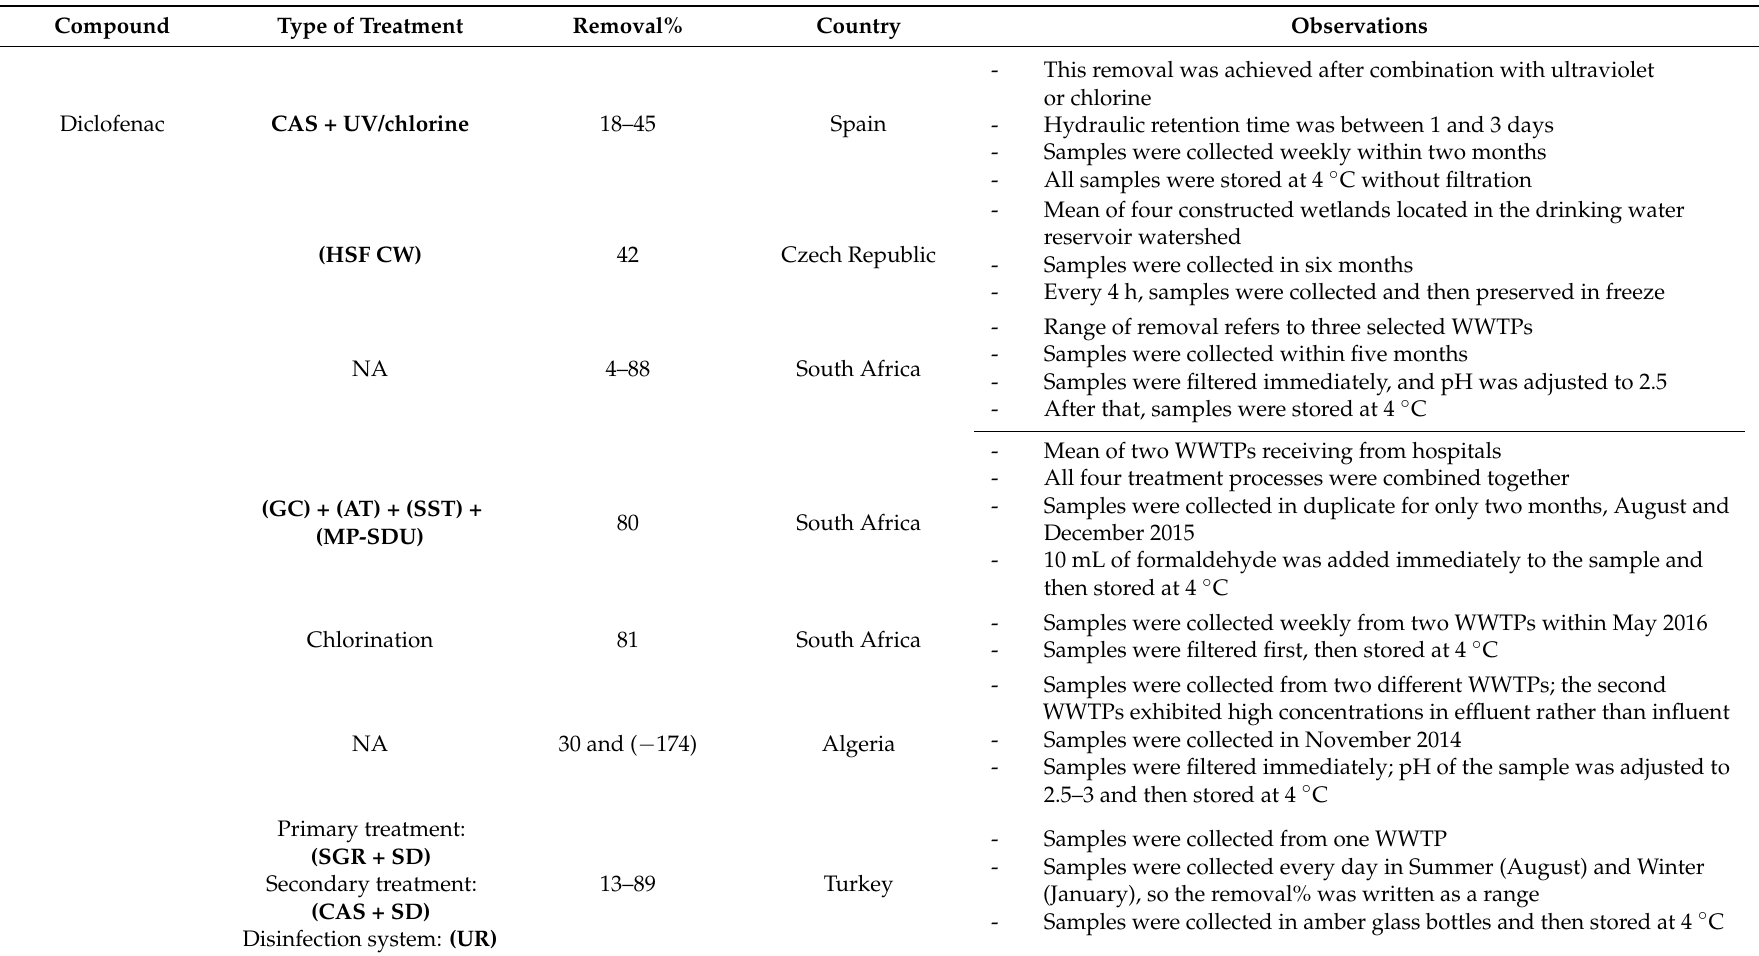
Table 3. Applied treatment of the selected NSAIDs from wastewater treatment